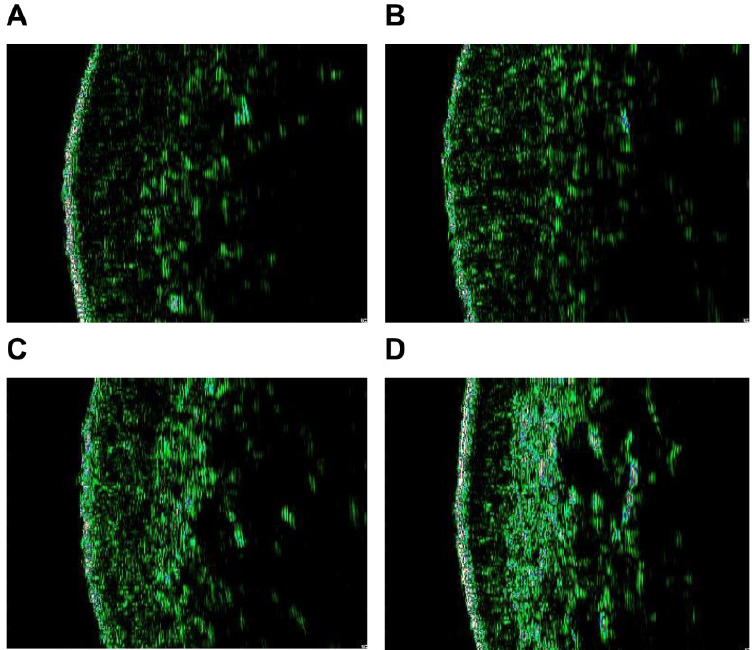
Figure 6. Skin density photo results. Subject 2: Skin density before treatment ( A ) and 1 week after the last treatment ( B ). Subject 3: Skin density before treatment ( C ) and 1 week after the last treatment ( D ).